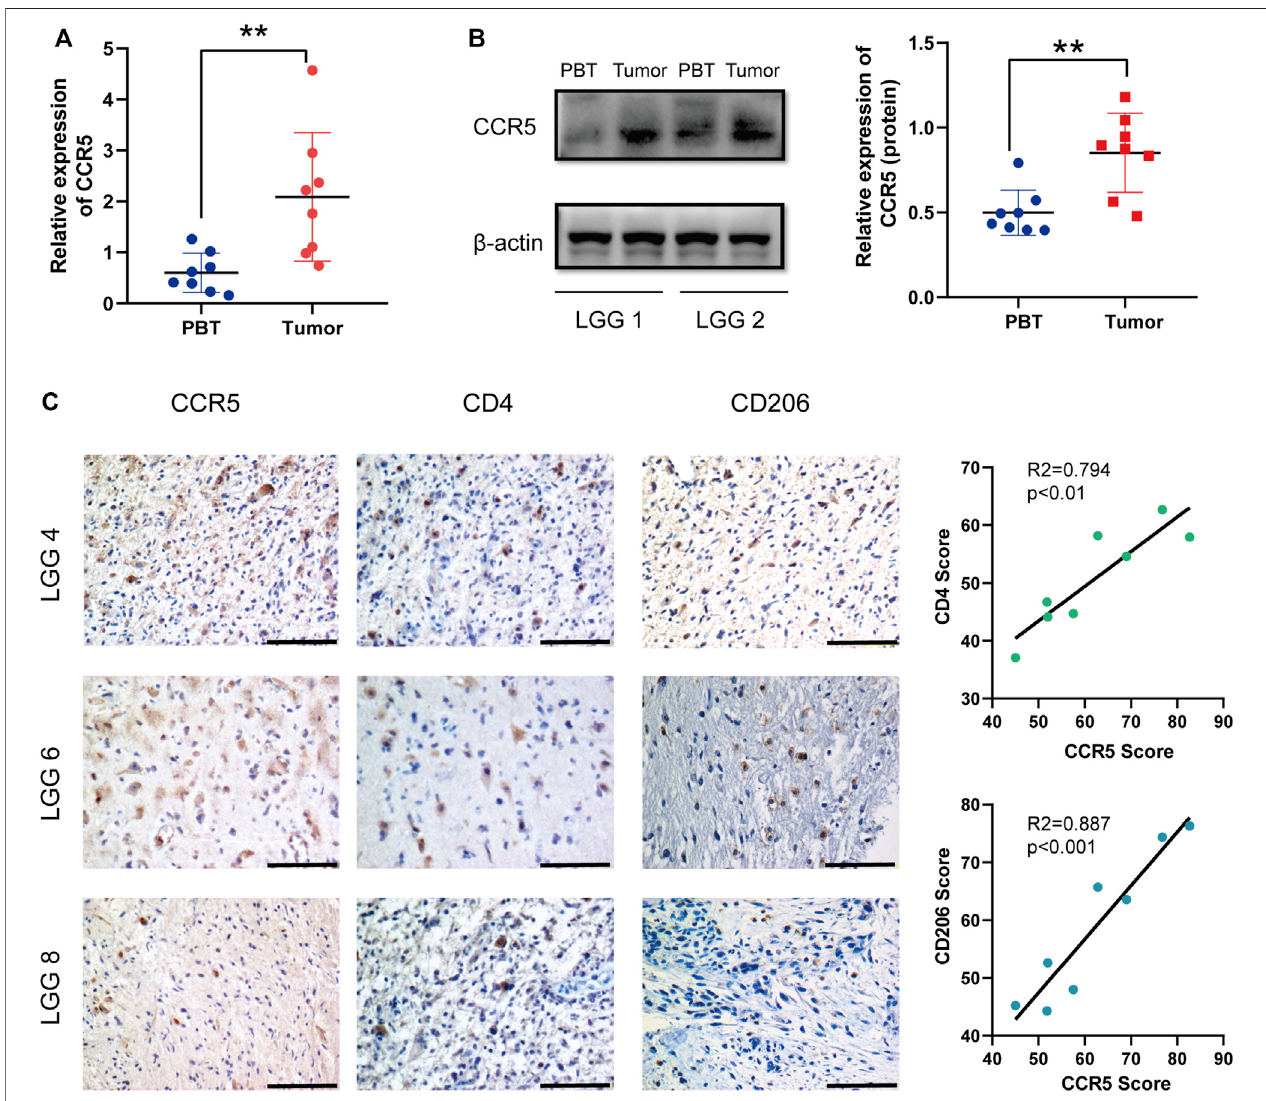
FIGURE8| CCR5 isupregulatedin LGGtissuesand mayaffecttheimmune cell in fi ltration. qRT-PCR (A) and Western blot (B) wereused todetectthe expression of CCR5 in PBT and tumor of LGG patients ( n = 8), ** p < 0.01. Representative IHC staining images of the expression of CCR5 and the number of CD4 + T cells and M2 macrophages. The CCR5 score was positively correlated with the CD4 score and CD206 score (scale bar, 100 μ M) (C) .